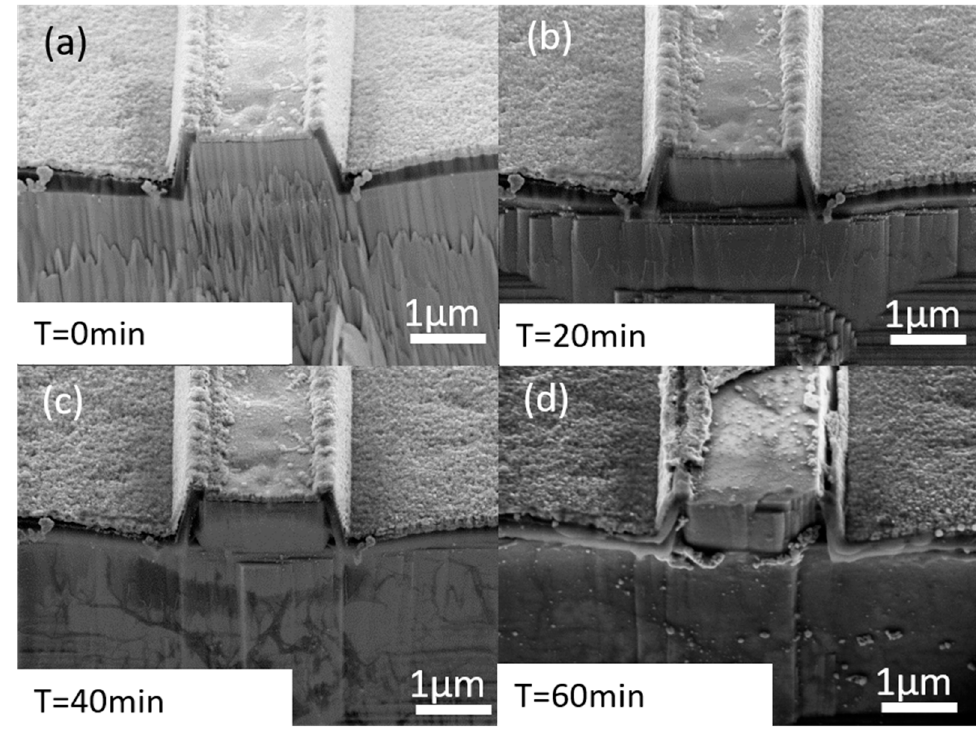
Figure 4. SEM images of the laser facet after: ( a ) only RIE, ( b ) RIE + 20 min TMAH, ( c ) RIE + 40 min TMAH, ( d ) 60 min TMAH.